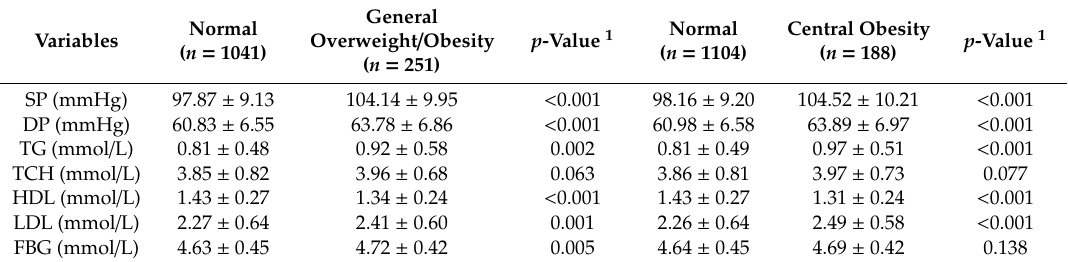
Table 1. Obesity-related variables compared by general overweight / obesity, central obesity, and normal.